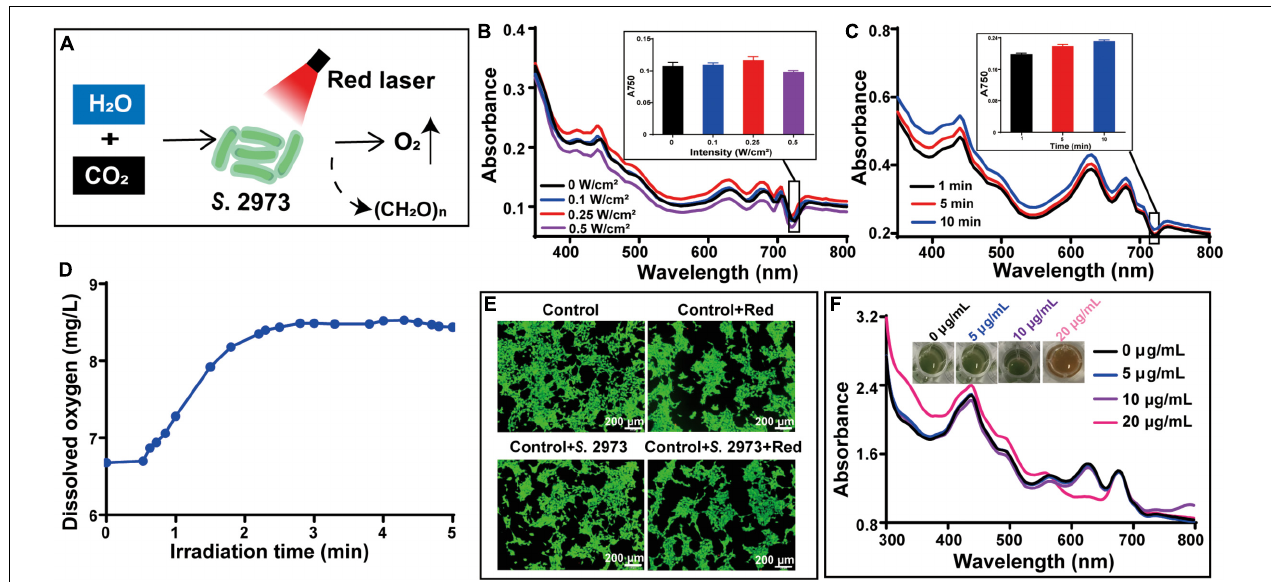
FIGURE 3 | Construction and characterization of the bio-oxygen pump in vitro . (A) Scheme of oxygen generation system based on S. 2973 under 640 nm red laser irradiation. (B) Absorption spectrum and OD 750 nm of S. 2973 irradiated using 640 nm laser with different intensities. (C) Absorption spectrum and OD 750 nm of S. 2973 irradiated using 640 nm laser with 0.25 W/cm 2 for different times. (D) Oxygen evolution of S. 2973 under 640 nm red laser irradiation. (E) Cell viability and AM/PI staining of 4T1 cells with or without treatments (i.e., 640 nm laser irradiation, co-cultivation with S . 2973 or both of them) for 24 h. (F) Phenotypes of S . 2973 treated with different concentrations of ICG exposed to 2 W/cm 2 of 808 nm laser for 5 min.